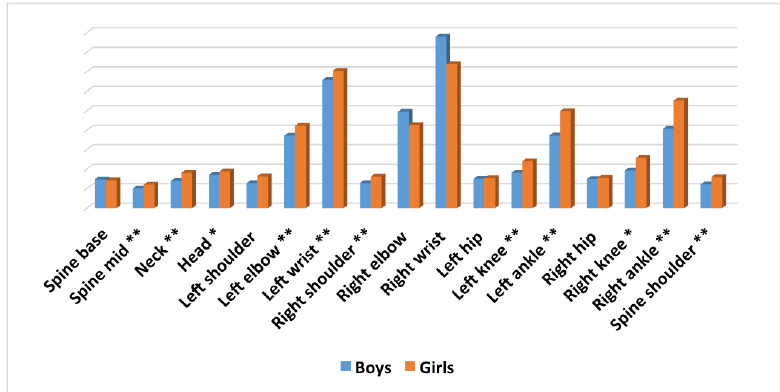
Figure 10. Average differences in movement for every joint in the experimental group, according to sex. ** = p < 0.001; * = p <